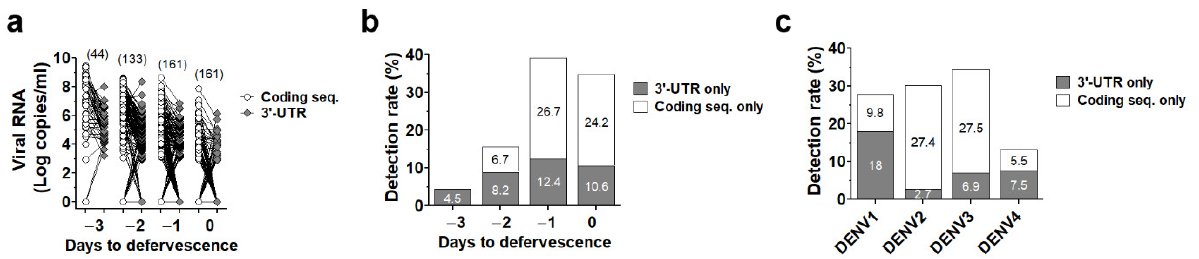
Figure 3. Rate of DENV genome detection by real-time RT-PCR specific to only 3 (cid:48) -UTR or coding sequence. ( a ) Viral RNA levels in plasma of 161 DENV infected patients collected since the first day of hospitalization to the day to defervescence quantified by RT-PCR specific to 3 (cid:48) -UTR (gray circles) or coding sequence (white circles) were re-analyzed according to “Day to defervescence”. The number of samples are labeled on the top of each group. Detection rate of DENV detected by only 3 (cid:48) -UTR (gray bar) or only coding sequence (white bar) were analyzed according to “Day to defervescence” ( b ) or DENV serotypes ( c ).